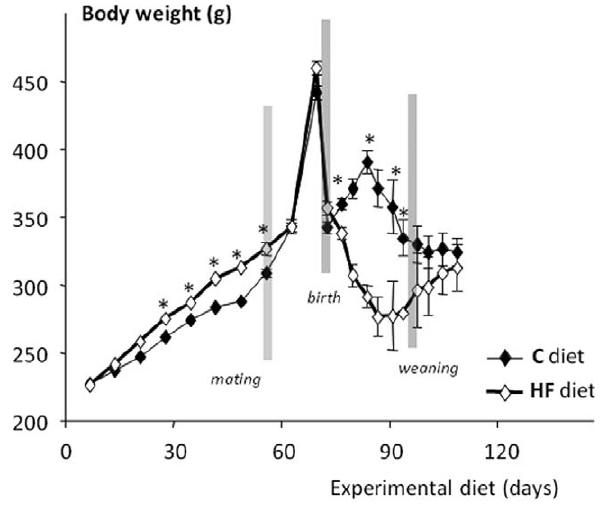
Figure 5. Evolution of the body weight of dams fed the control (C) diet (n=28) or high-fat diet (HF) (n=28) for 6 wk before mating, throughout gestation and lactation (28 days) and until the postweaning period (*p , 0.05).